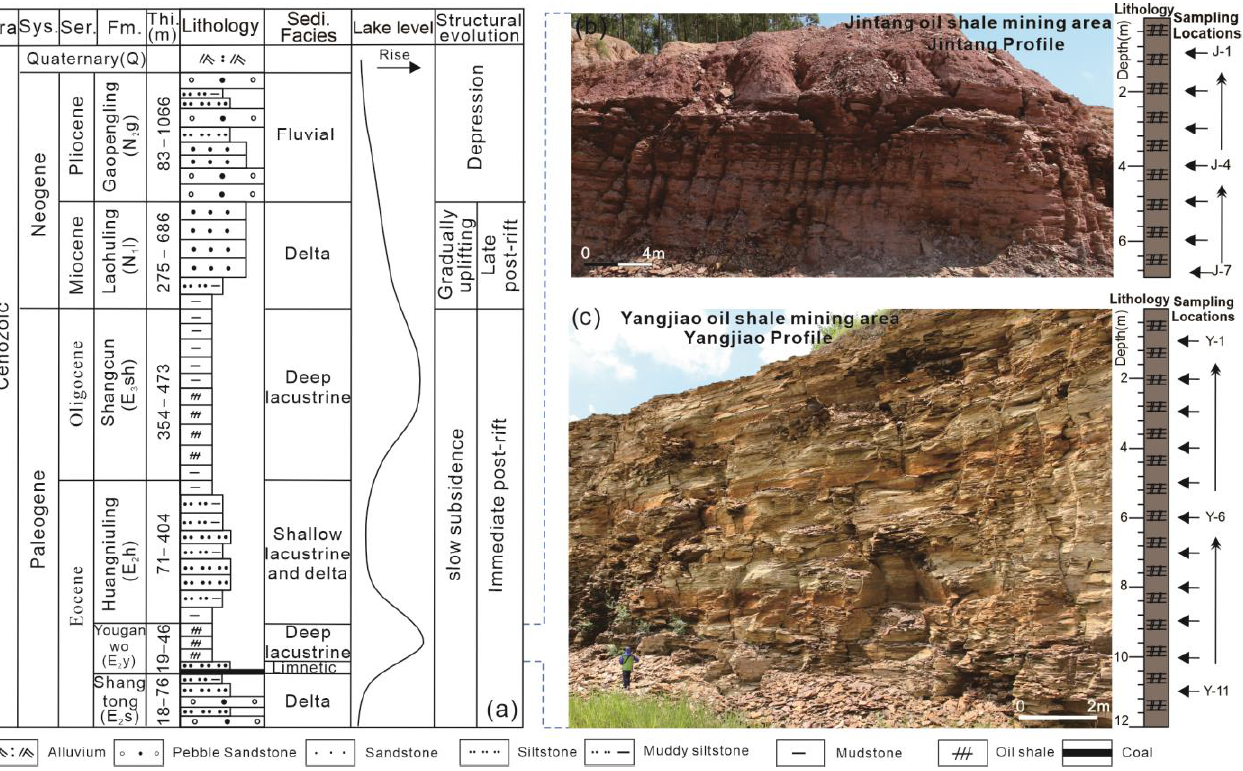
Figure 2. Comprehensive stratigraphic histogram and sampling section of Maoming Basin. ( a ) : comprehensive stratigraphic histogram of Maoming Basin; ( b ) : sampling profile of Jintang mining area; ( c ): sampling profile of Yangjiao mining